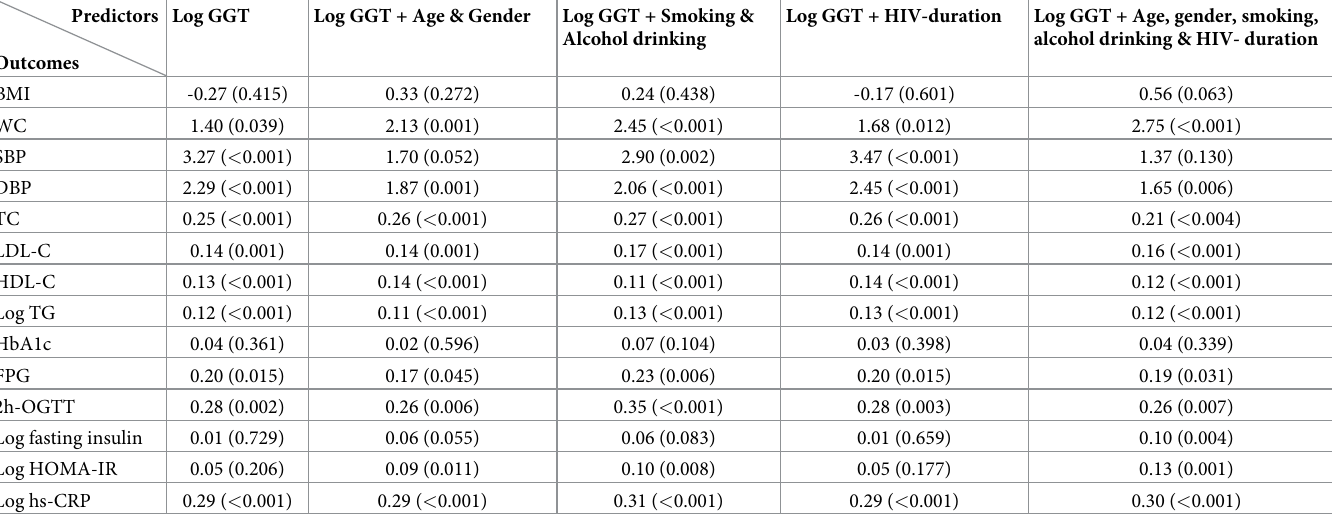
Table 2. Linear regressions for the associations of Gamma-Glutamyl Transferase (GGT) with cardio-metabolic risk markers,